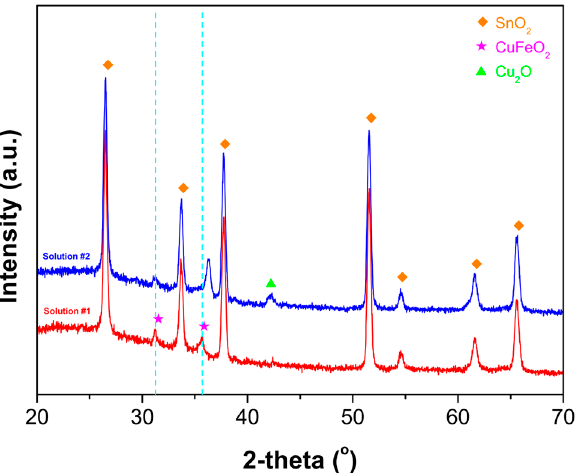
Figure 2. XRD patterns of electrodeposited CuFeO 2 film by applying a current density of − 0.2 mA cm − 2 for 60 min in DMSO based electrolytes with different potassium perchlorate concentrations. Solution #1 (red) contained 1 mM Cu(NO 3 ) 2 ∙ xH 2 O/3 mM Fe(ClO 4 ) 3 ∙ xH 2 O/100 mM potassium per-